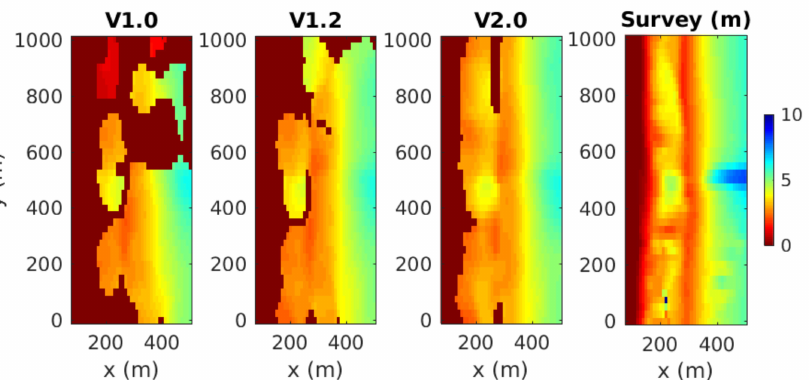
Figure 8. Comparison of bathymetry from the three versions of cBathy, V1.0, V1.2, and V2.0 (left three panels) for 19 November 2017, 1959 GMT, with the ground-truth survey from two days following (right panel). All cBathy results have been filtered to remove any values with an estimated error greater than 0.5 m (dark red